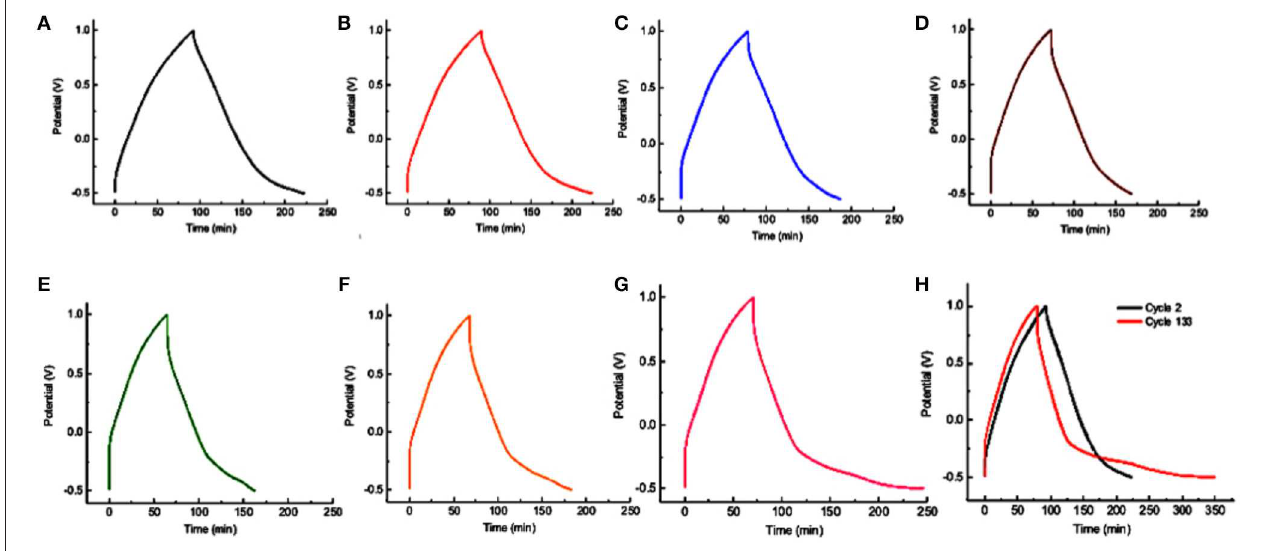
FIGURE 9 | Long-term charge-discharge cycles for NDRGO-Mo-Li-2S. (A) Cycle number 3. (B) Cycle number 23. (C) Cycle number 43. (D) Cycle number 63. (E) Cycle number 83. (F) Cycle number 103. (G) Cycle number 123. (H) Comparing the charge-discharge profile of cycle number 2 vs. cycle number 133.